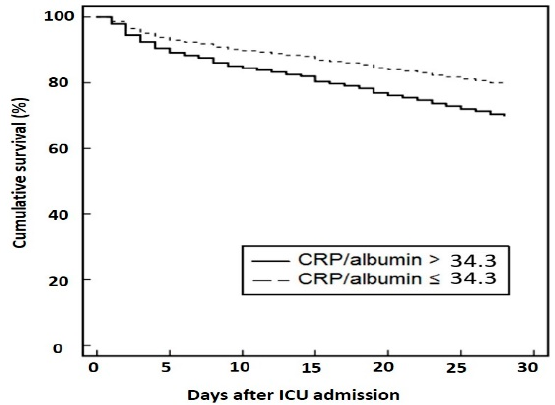
Figure 3. Kaplan-Meier survival curve according to the serum CRP/albumin ratio. For survival analysis, patients were divided into two groups according to CRP/albumin ratios. The cut-off value was 34.3. The relative risk of mortality was significantly associated with the CRP/albumin ratio ( p = 0.001).